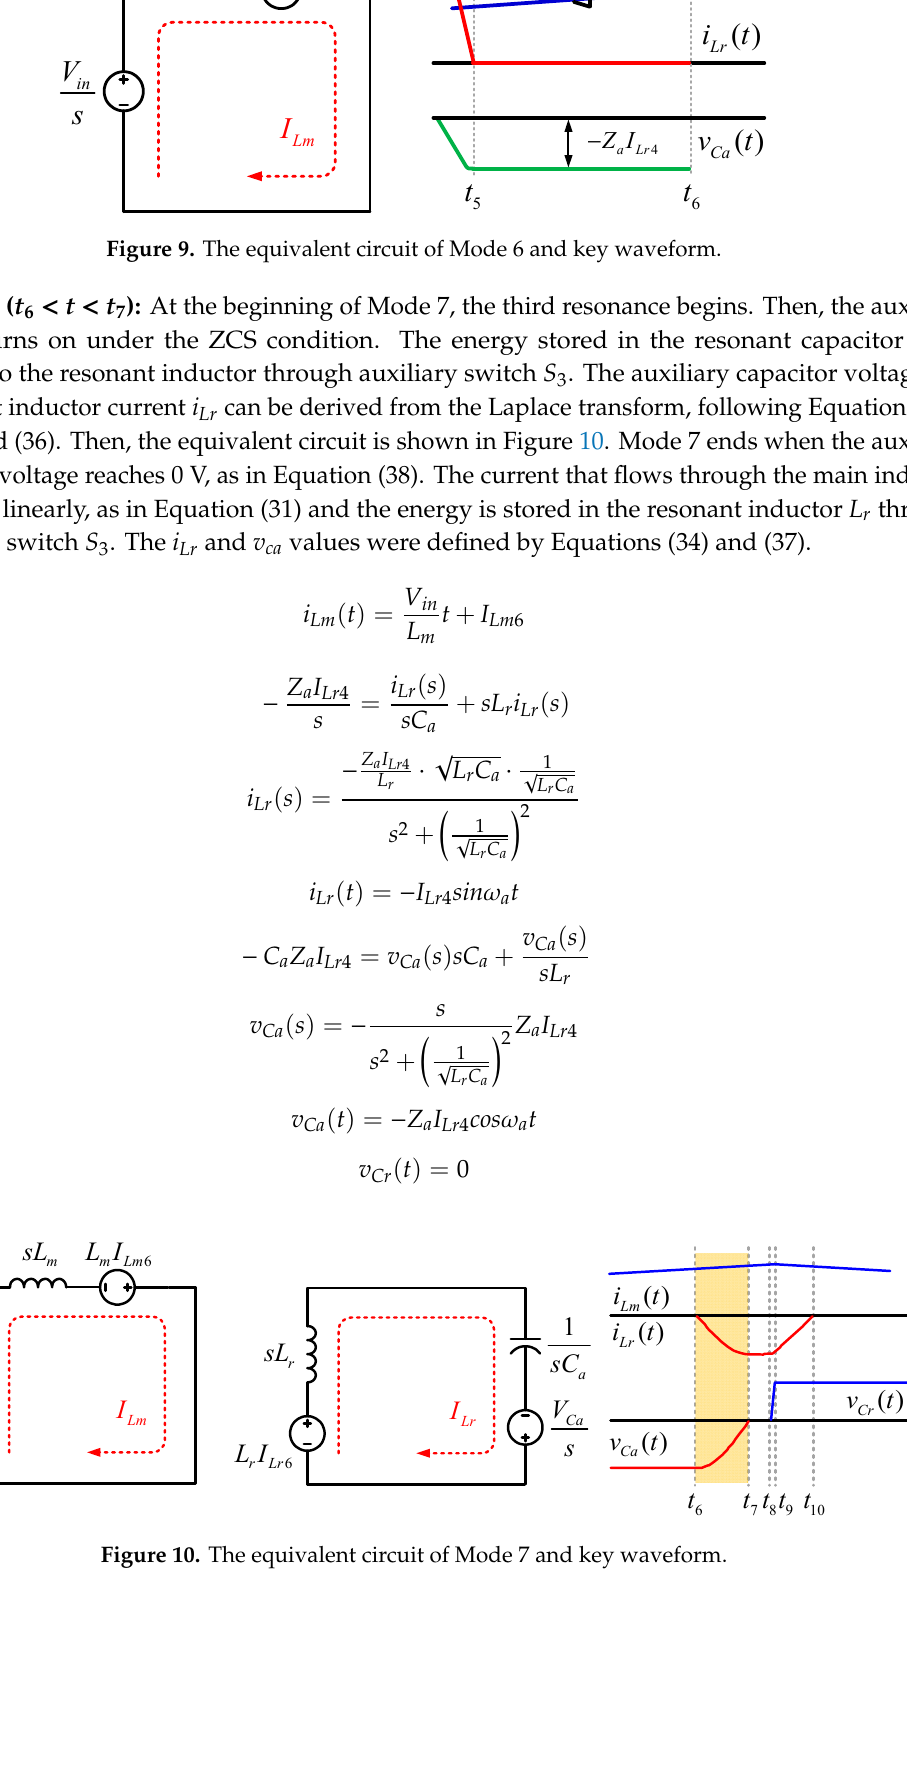
Figure 11. The equivalent circuit of Mode 8 and key waveform. Figure 12. The equivalent circuit of Mode 9 and key waveform. Figure 13. The equivalent circuit of Mode 10 and key waveform.